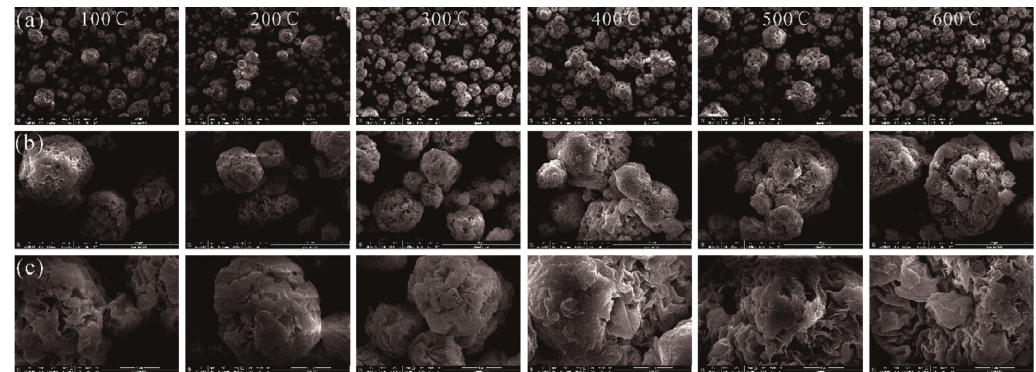
Figure 5: Effect of heating on the specimen microstructure shown at magnifications of (a) 2000, (b) 6000, and (c) 20,000.